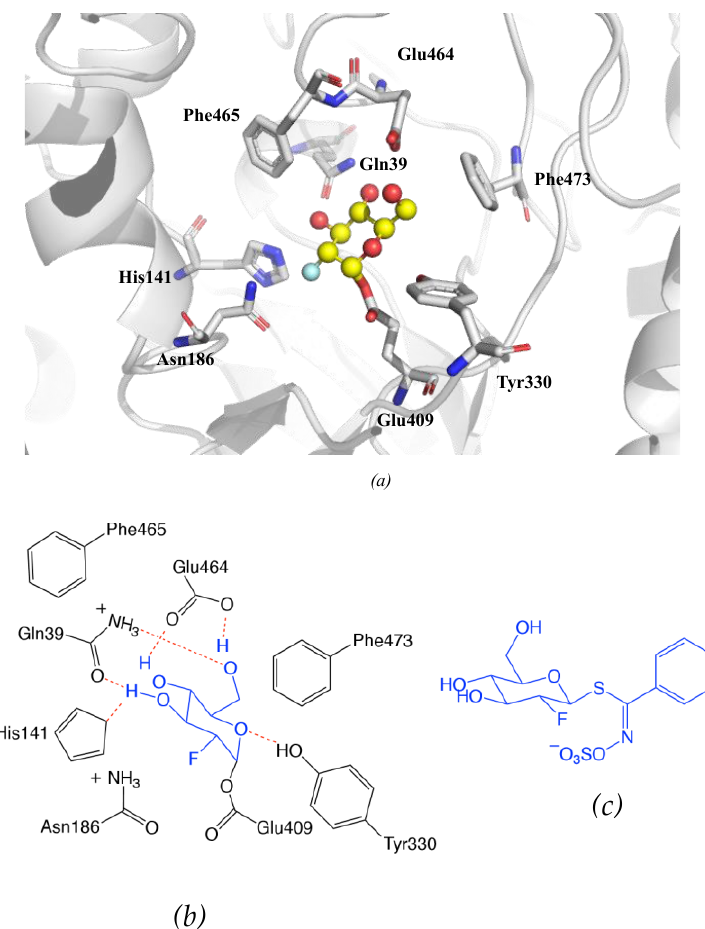
Figure 9. Overview of the active site of Sinapis alba Myrosinase showing interactions between residues and the 2-deoxy-2-fluoroglucosinolate (2FG) as substrate (Protein Data Bank accession number 1E70, resolution: 1.65 Å) [172]. Red dashed lines show hydrogen bonding interactions between the substrate and MYR residues within the active site. ( a ) Representation of the active site of Sinapis alba Myrosinase generated using PyMol. ( b ) Chemical structure representation of the MYR-2FG. ( c ) Structure of 2-deoxy-2-fluoroglucosinolate.